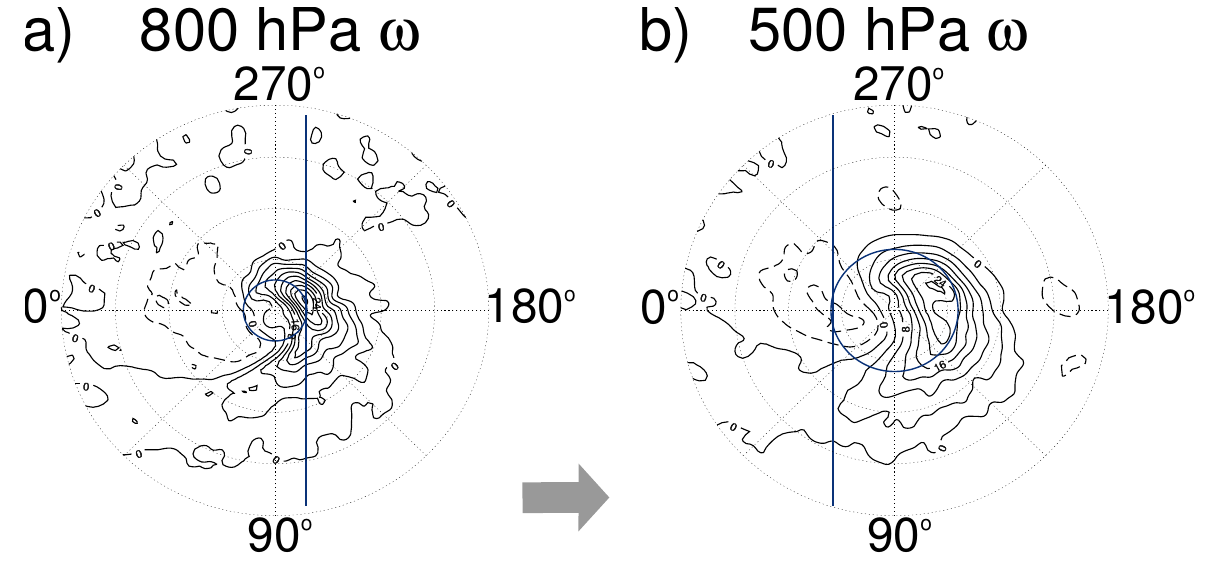
Figure 7. 95th percentile MAM storm tracks for the NP region during 2003–2012: (a) storm-centered composite 800hPa ω (4hPah − 1 contour intervals, with positive values (solid lines) indicating ascent and negative values (dashed lines) indicating descent) with the blue line showing the location of the transect taken 3 ◦ to the right of storm center to capture the WCB for Figs. 8 and 11 and the blue circle taken at 3 ◦ radius around the storm center for Fig. 9; and (b) storm-centered composite 500hPa ω (4hPah − 1 contour intervals) with the blue line showing the location of the transect taken 6 ◦ to the left of the storm center to investigate the DI in Figs. 12 and 13 and the blue circle taken at 6 ◦ radius around the storm center for Fig. 10. Storm propagation is toward the right as indicated by the large grey arrow. Radial dotted lines are plotted every 45 ◦ , and dotted circles represent 5, 10, 15, and 20 ◦ radii from storm